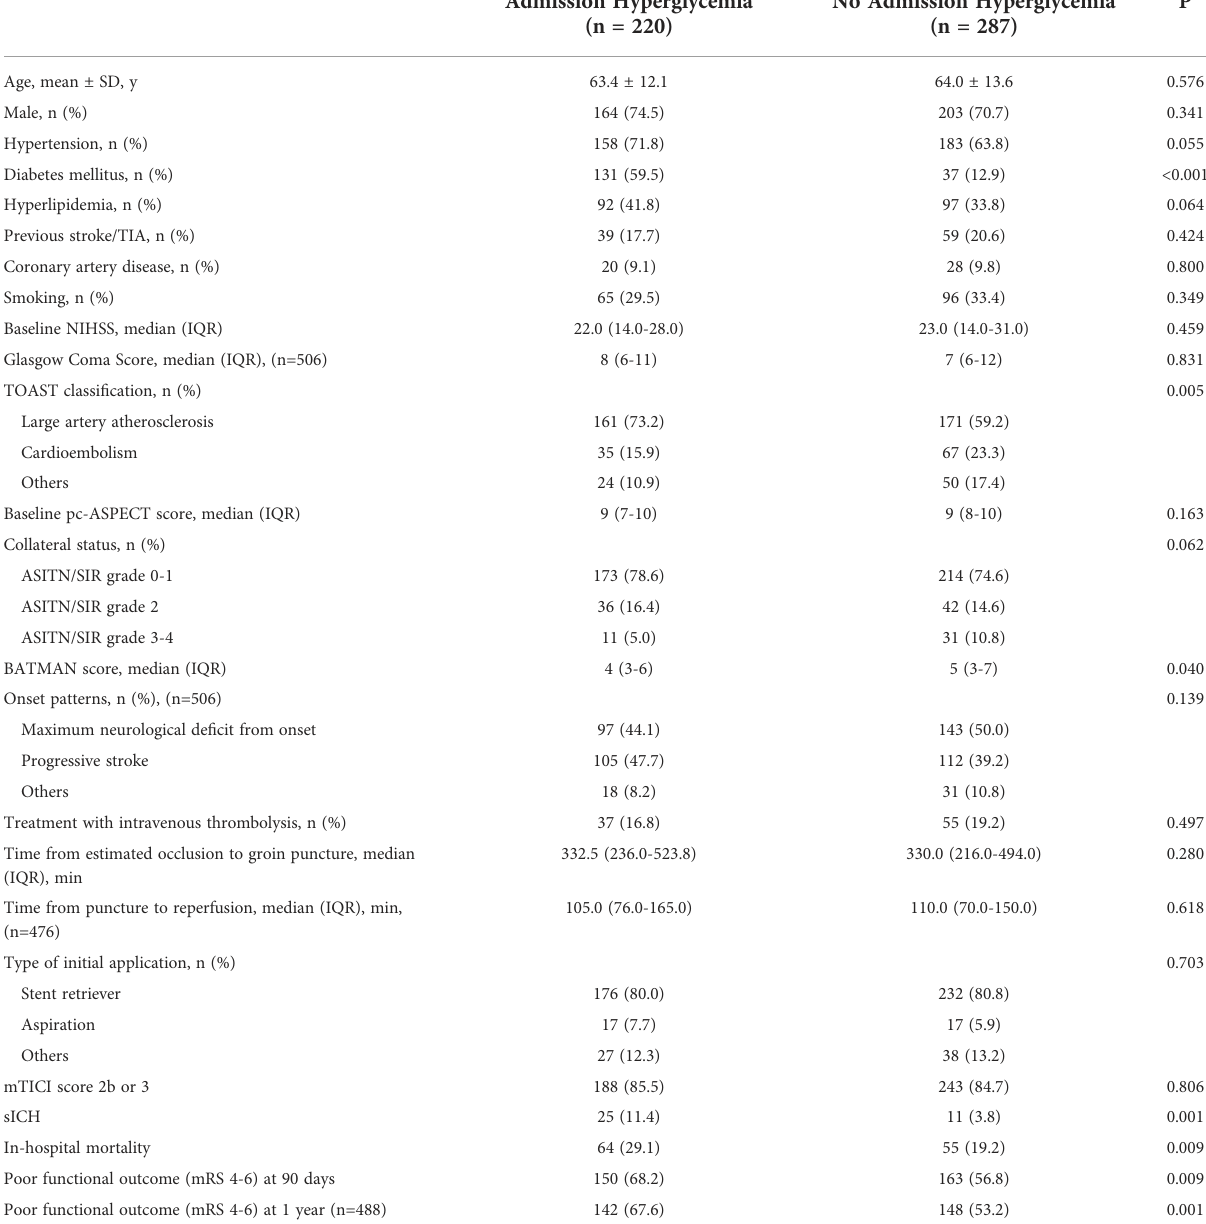
TABLE 1 Baseline characteristics